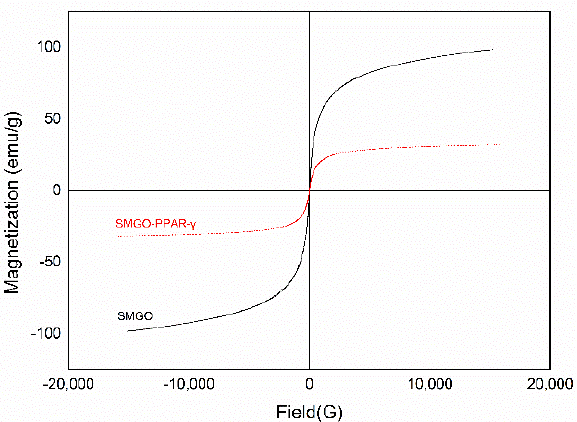
Figure 1. Magnetization curves of SMGO and SMGO − PPAR − γ at room temperature.